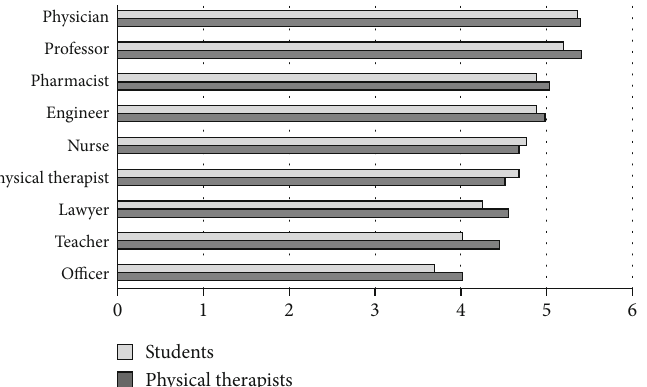
Figure 1: Mean ranks for level of education.